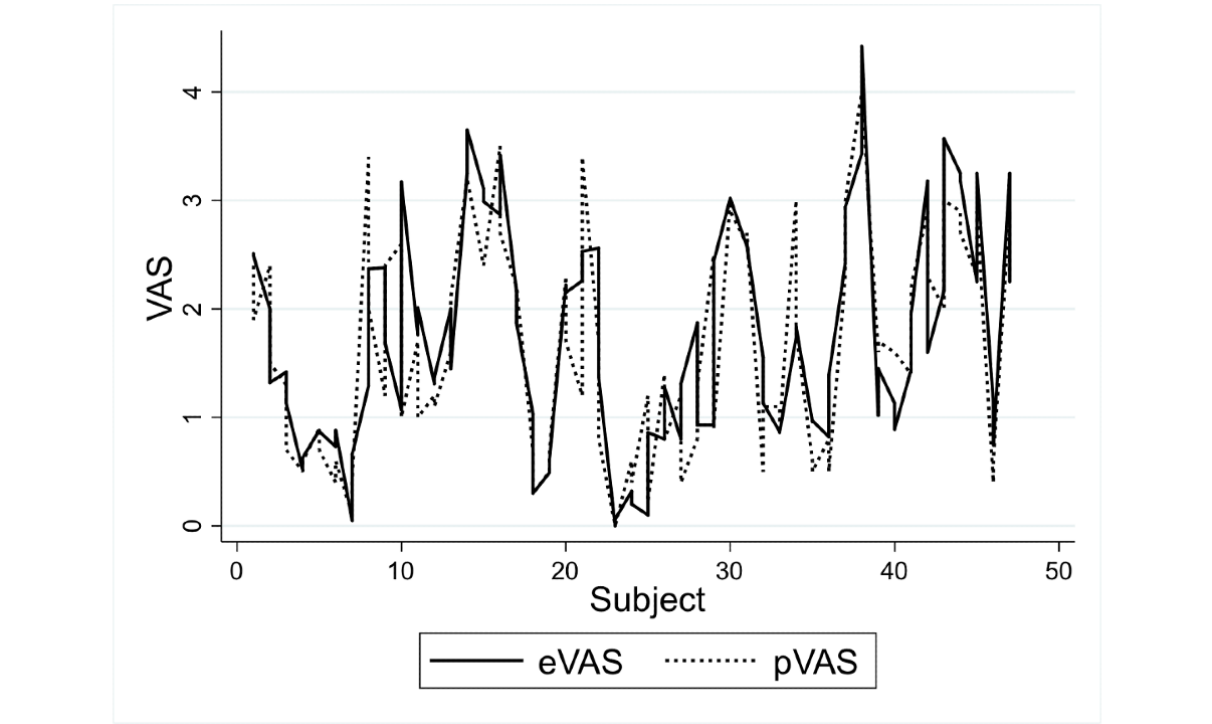
Figure 7. Rating data for the two methods in children and adolescents. eVAS: electronic visual analog scale; pVAS: paper visual analog scale.